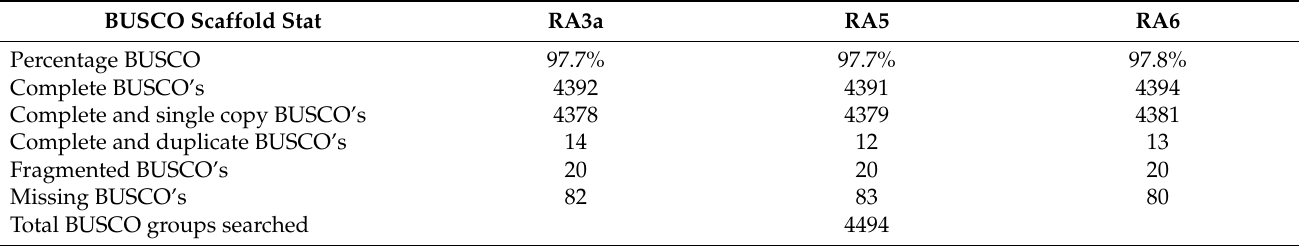
Table 5. Scaffold BUSCO: dataset Hypocreales odb10 for the genomes of the fungal isolates RA3a, RA5, and